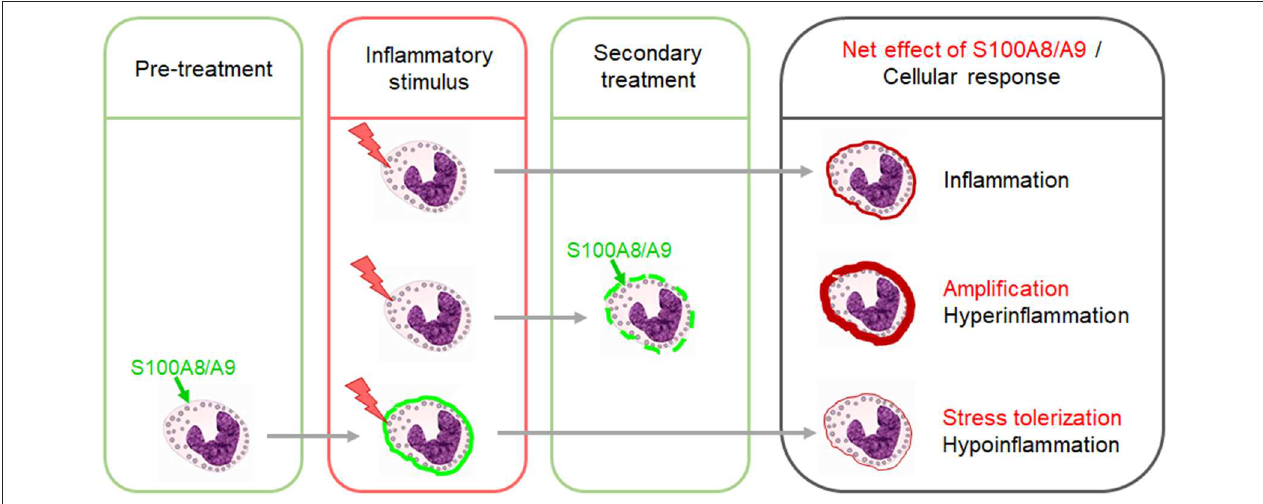
FIGURE 1 | Dual impact of S100A8/A9 on the outcome of inflammatory responses. The secondary release of S100A8/A9 during an inflammatory response upon a preceding stimulus has amplifying effects. Excessive S100A8/A9 release in such settings increases the risk of hyperinflammation. In contrast, pretreatment of immune cells with S100A8/A9 induces a state of hyporesponsiveness of innate signaling pathways which dampens the response to subsequent inflammatory stimuli.